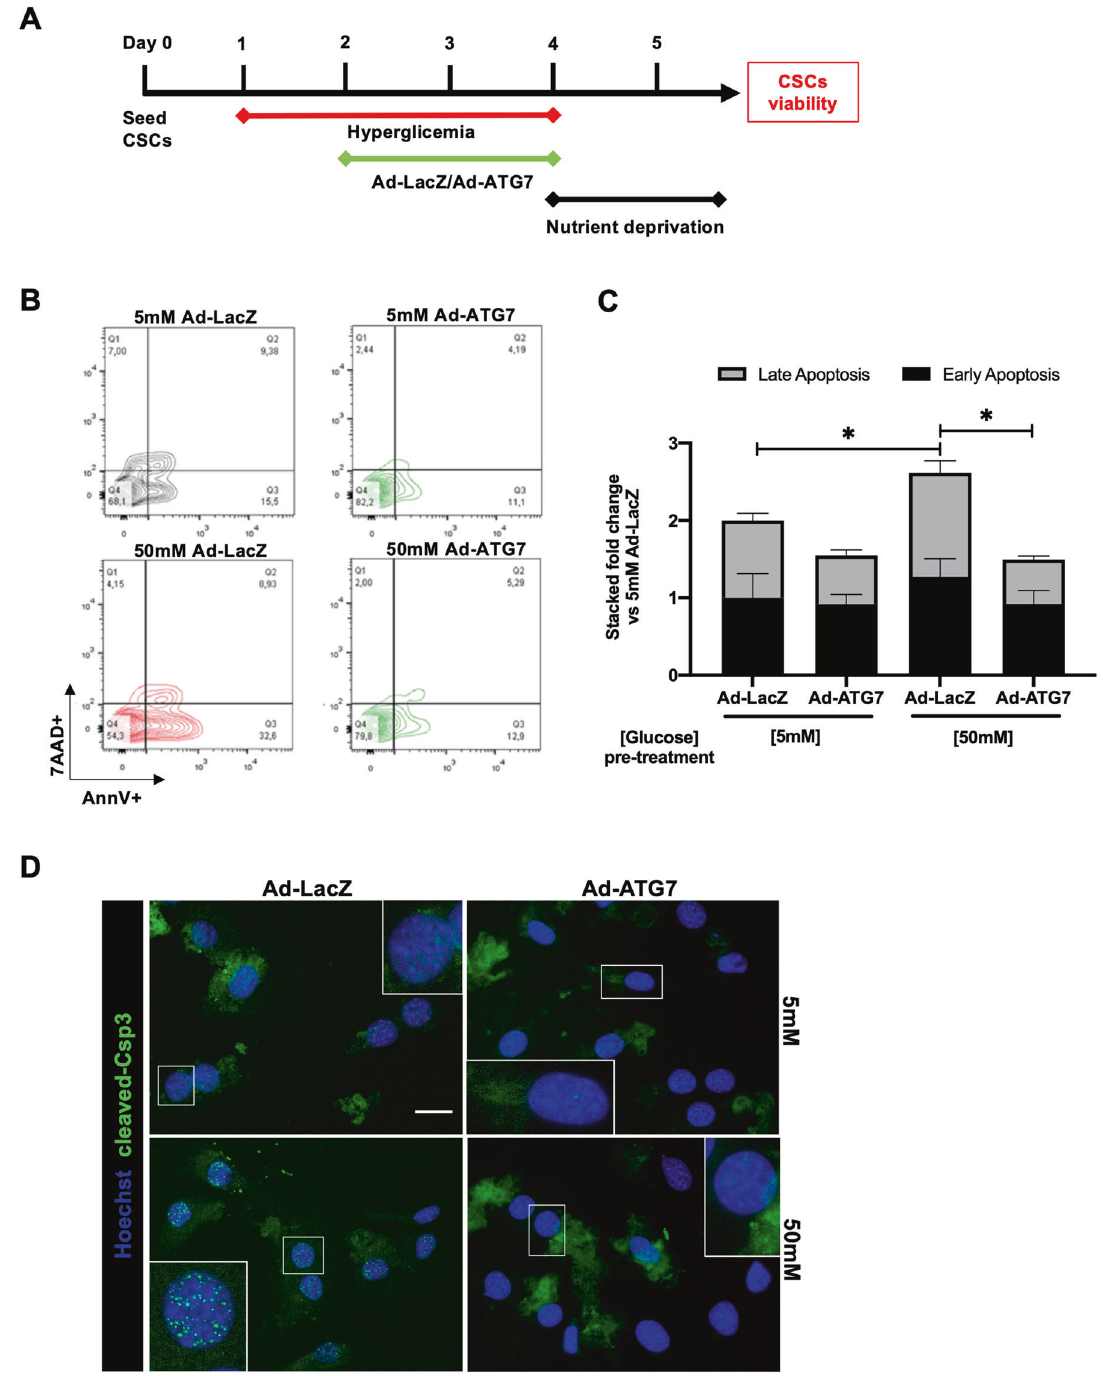
Fig. 8 Autophagy induction protects CSCs from hyperglycemia-impaired stress resistance. A Experimental timeline of hyperglycemia (50 mM) pretreatment for 72 hours, with parallel ad-ATG7/ad-LacZ transduction for autophagy modulation, followed by 32 hours of nutrient deprivation stress (0.1% FBS, 0 mM glucose). Representative fl ow cytometry density plots (B) and relative quanti fi cation (C) of early (Annexin-V + /7AAD-) and late (Annexin-V + /7AAD + ) apoptotic CSCs, to evaluate hyperglycemia-impaired and autophagy-enhanced resistance to nutrient deprivation stress ( n = 4). Representative immuno fl uorescence panels are displayed with higher magni fi cation insets (D) , showing differential nuclear translocation of cleaved caspase 3 (Csp3) in the different conditions. * P <0.05. Scale bar = 20 induced a signi fi cant increase in CSC survival. Conversely, ATG7 Our results show increased activation of autophagy in CSCs downregulation exacerbated cell death. These data con fi rm the exposed to nutrient deprivation, in line with the known protective concept that autophagy can increase the resilience of cardiac cells role of this degradation system in response to energy stress (now including CSCs) towards nutrient deprivation in ischemic [63, 64] or oxidative stress [65]. Autophagy boosting with both settings. ATG7-overexpression and TRE treatment before starvation